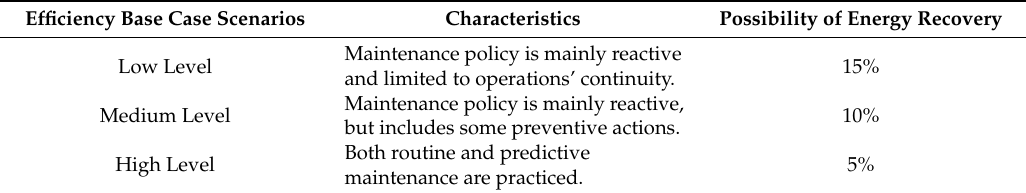
Table 1. Efficiency base case